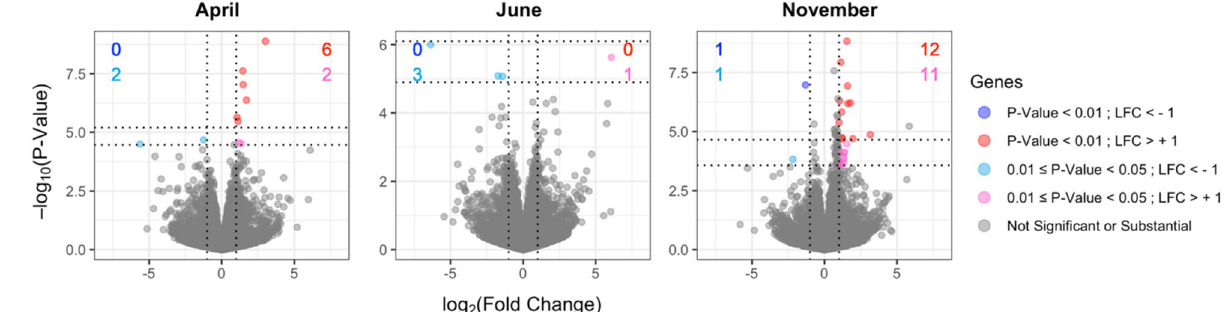
Figure 3. Sexually differential expression pairwise comparisons between sexes for each time point. Volcano plots of sex-wise comparisons for each month are displayed. LFC is the log 2 (fold change) of gene expression. Other plot details are the same as in Fig.